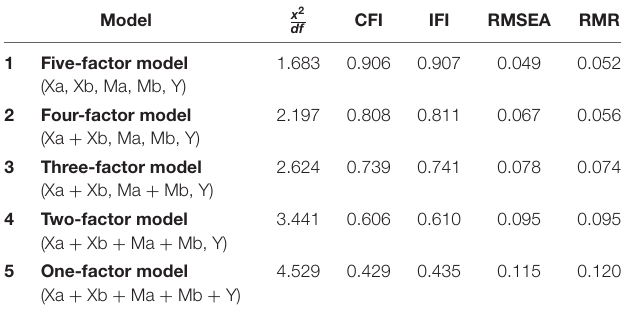
TABLE 1 | Confirmatory factor analysis.